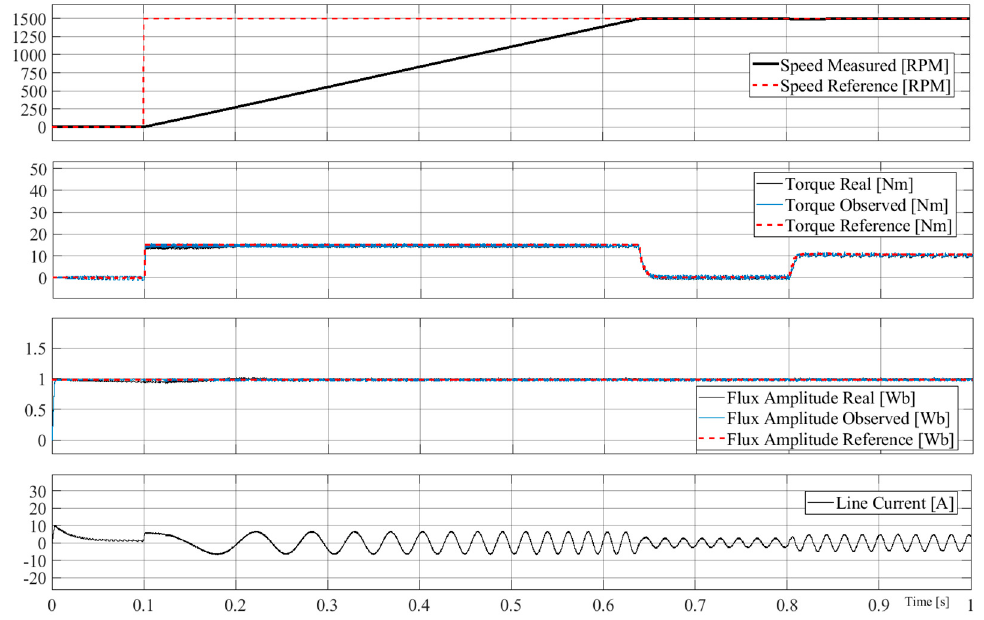
Figure 7. Startup of the motor from 0 to 1500 RPM—star-connected winding.